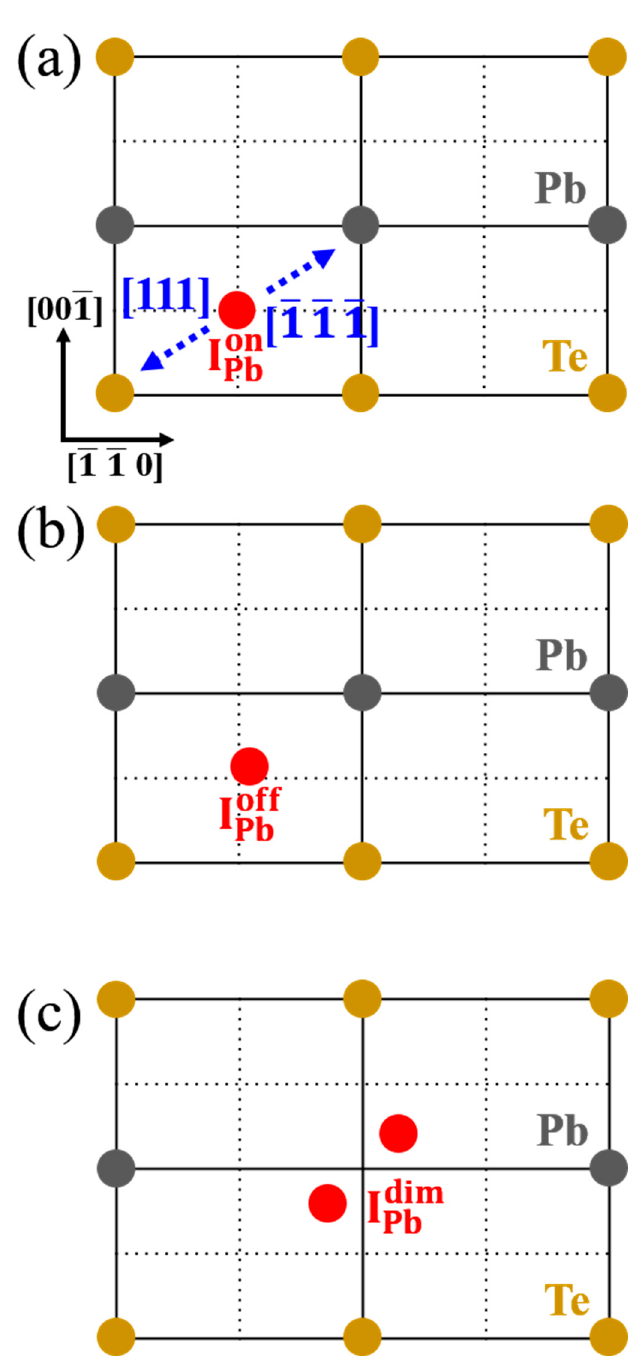
Figure 3. Schematic atomic structures projected to the (110) plane of Pb interstitial at ( a ) the on- centered position (I on ), ( b ) the off-centered position (I off ), and ( c ) the Pb-dimer (I dim ) position. I on is located at the center of the subcubic domain, and I off is slightly displaced from the center of the subcubic domain to one of the four nearest host Pb atoms. In addition, I dim involves the formation of a Pb dimer by farther moving of a Pb interstitial toward one of the four nearest Pb atoms. Each red dot indicates a Pb interstitial defect. The black and gold dots represent Pb and Te atoms, respectively. The black solid lines represent the (110) planes of the PbTe lattice, and the black dotted lines are a guide to the eye for the center of the subcubic domain. The blue arrows indicate the directions toward the nearest neighbor Pb ([ 1(cid:3364)1(cid:3364)1(cid:3364) ]) and the nearest neighbor Te ([111]) of Pb interstitial defect. In Figure 4, effects of symmetry breaking on the defect stability of I (cid:2900)(cid:2912)(cid:2925)(cid:2924) , I (cid:2900)(cid:2912)(cid:2925)(cid:2916)(cid:2916) , and I (cid:2900)(cid:2912)(cid:2914)(cid:2919)(cid:2923) (cid:2925)(cid:2924) for were first investigated. Note that Figure 1a includes only the formation energy of I (cid:2900)(cid:2912)